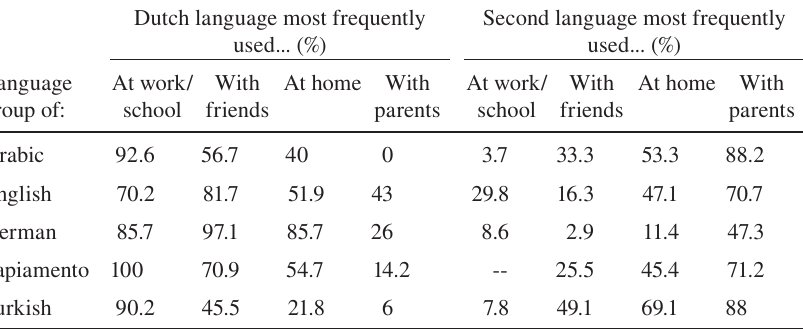
Self-reported language use in Dutch and a second